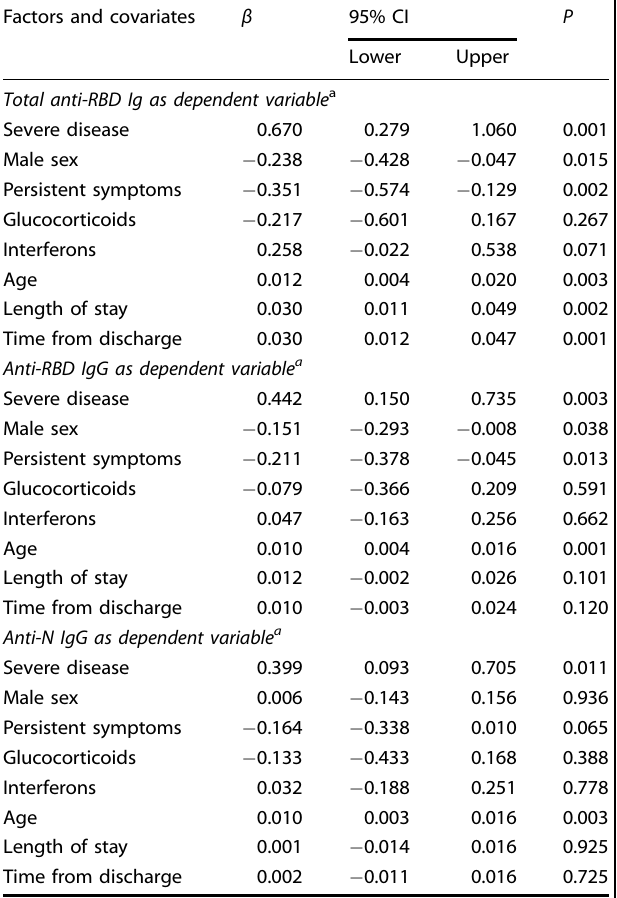
Table 2. Parameters of regression